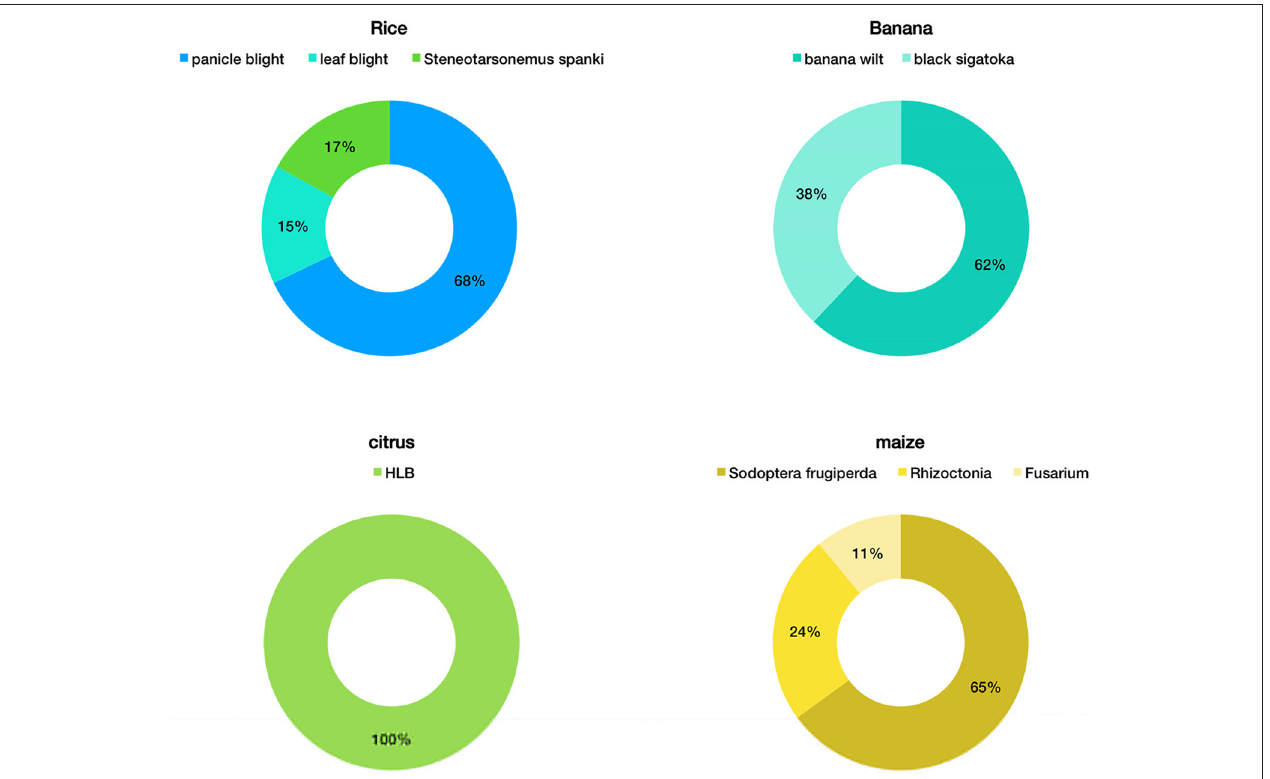
FIGURE 2 | Survey responses of 31 extension phytopathologists assessing their perceived percentage of important plant diseases that threaten food security in